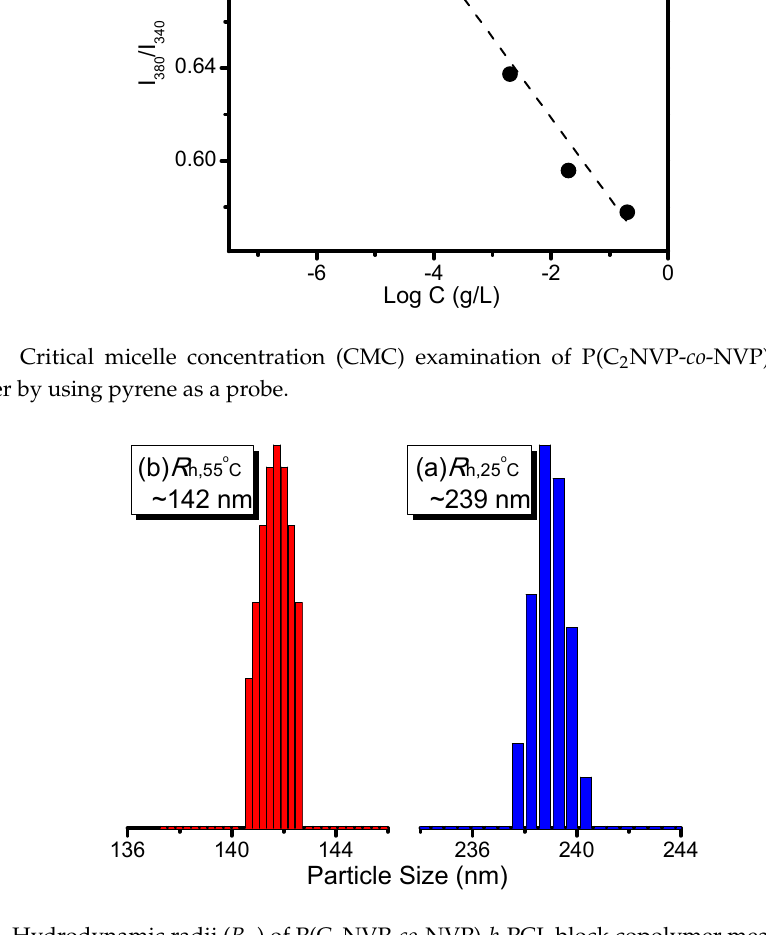
Figure 10. Hydrodynamic radii ( R h ) of P(C 2 NVP- co -NVP)- b -PCL block copolymer measured by DLS at ( a ) 25 °C and ( b ) 55 °C (conc. of BC1 = 0.002 g/L).